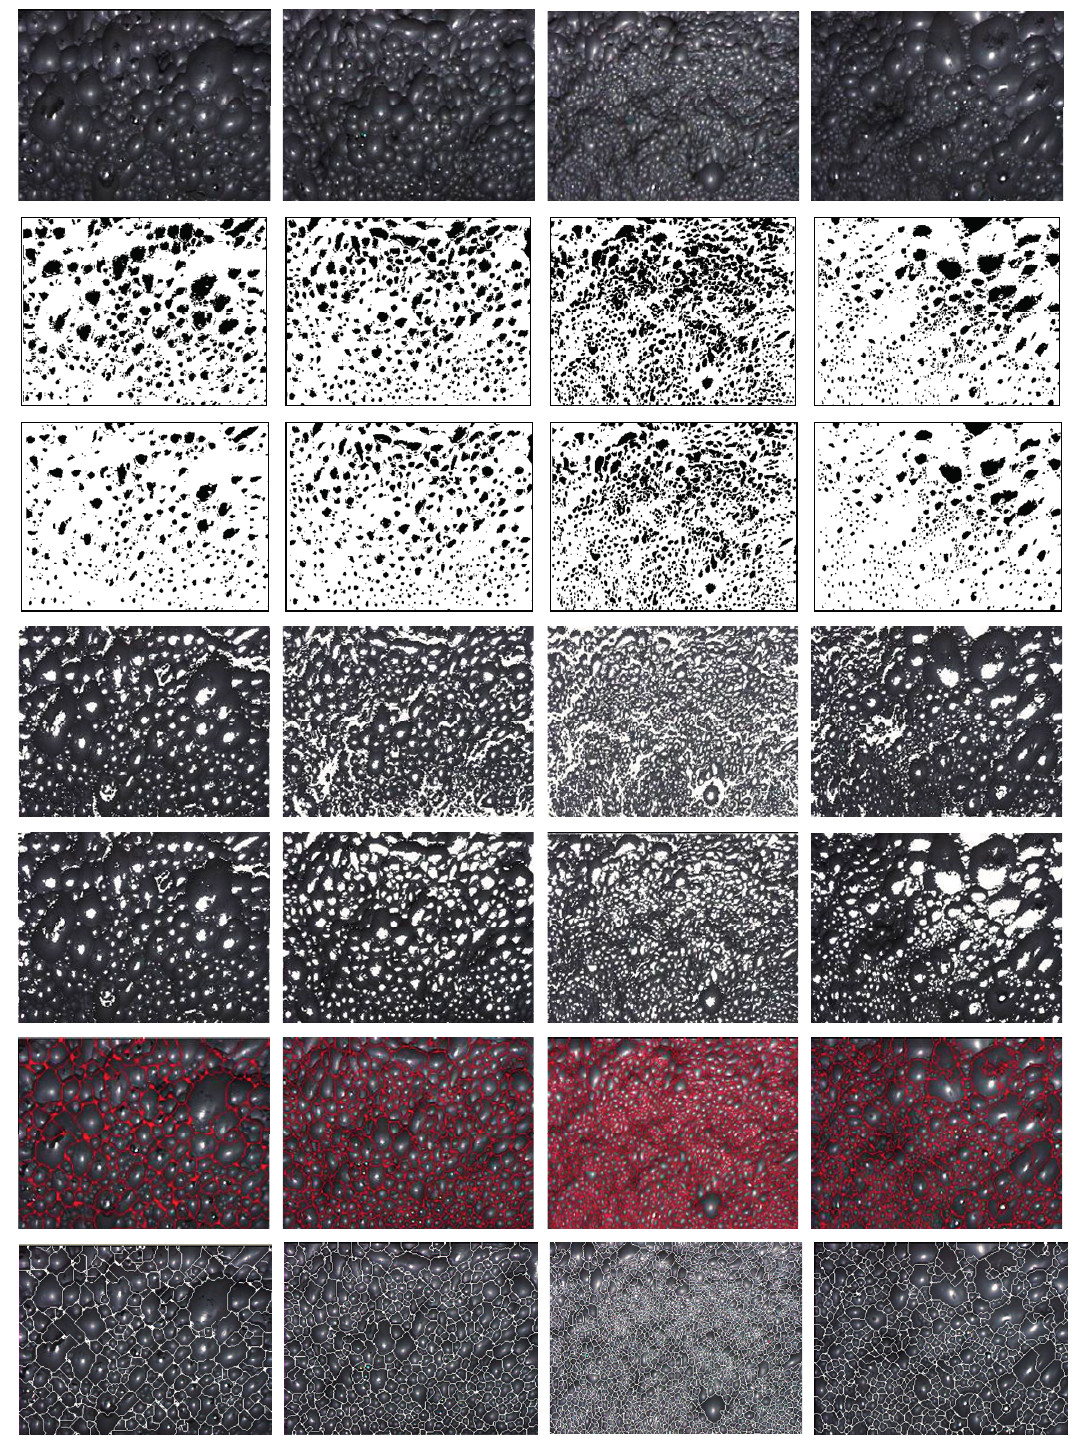
Figure 14. Comparison between the proposed algorithm and the algorithms based on gray value similarity: The first row is for the original images; the second row is for the segmentation results of the optimal threshold algorithm; the third row is for the results of Otsu threhsolding; the fourth and the fifth rows are for the results of the region growing algorithm with the threshold 30 and 35 separately; the sixth row is for the results of the proposed algorithm; the last row is for the results of manual